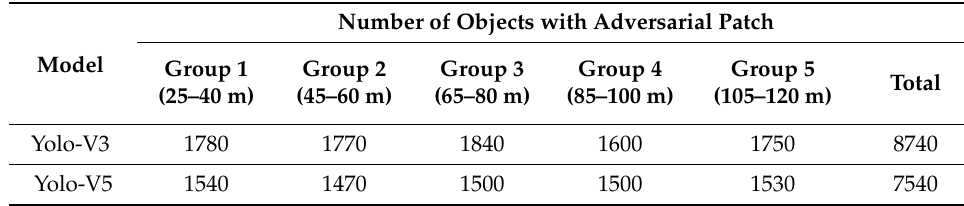
Table 3. The numbers of objects with adversarial patch for Yolo-V3 and Yolo-V5.